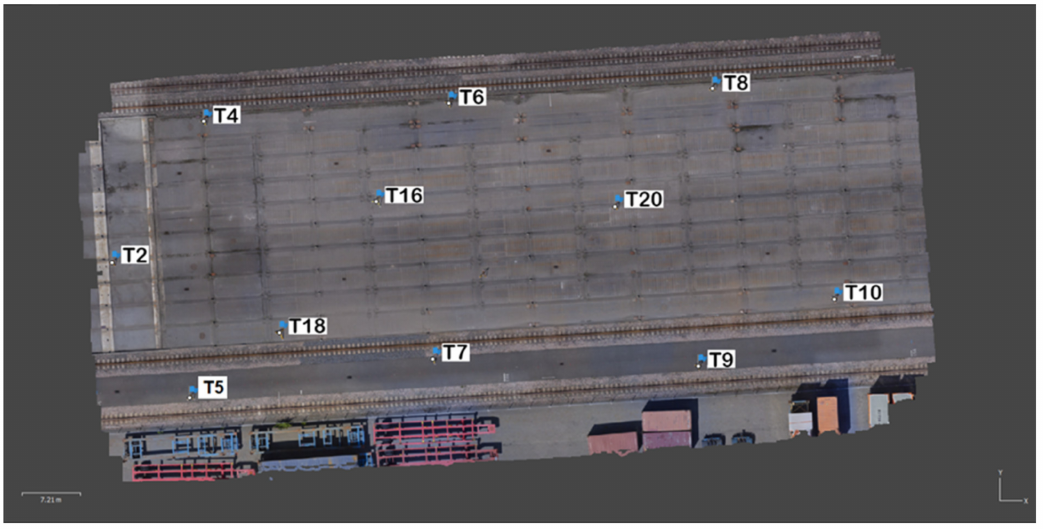
Figure 10. Ground point distribution over the flight area A.